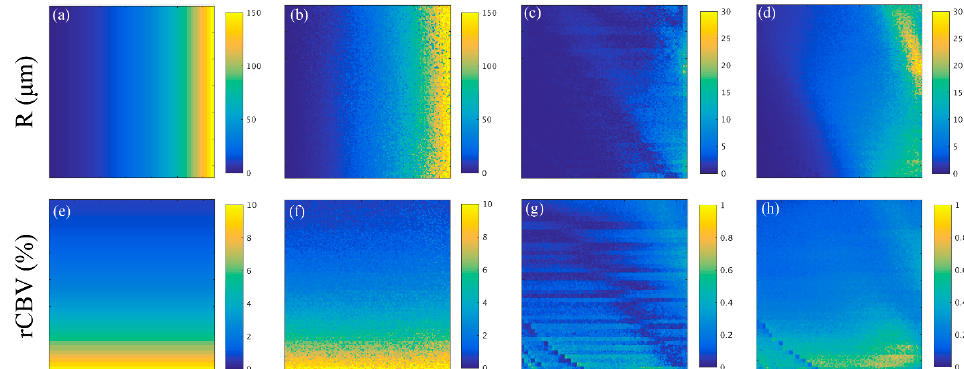
Figure 6. ( a ) and ( e ) are the vessel radius, R (in μ m) and rCBV (in %) maps of the synthetic image from the dictionary, respectively. R (in μ m) and rCBV (in %) estimated from matching one of the noisy datum to the original dictionary are shown in ( b ) and ( f ), respectively. ( c ) shows the difference in R (in μ m) between the values of the ground truth and the mean of the R estimates, and ( d ) is the standard deviation (in μ m) of the R maps estimated from the 100 noise realizations. ( g ) corresponds to the difference between the rCBV (in %) values of the ground truth and the mean of the rCBV, and ( h ) gives the standard deviation of the rCBV (in %) obtained from the 100 noise realizations.